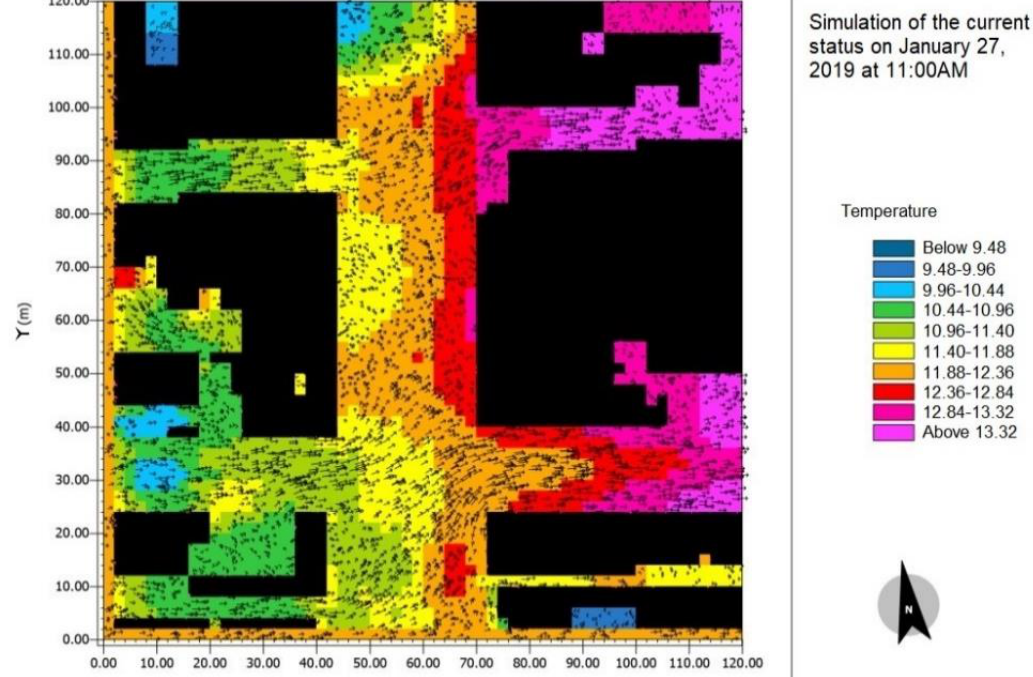
Figure 5. Simulation of 27 January 2019, for validation purposes.